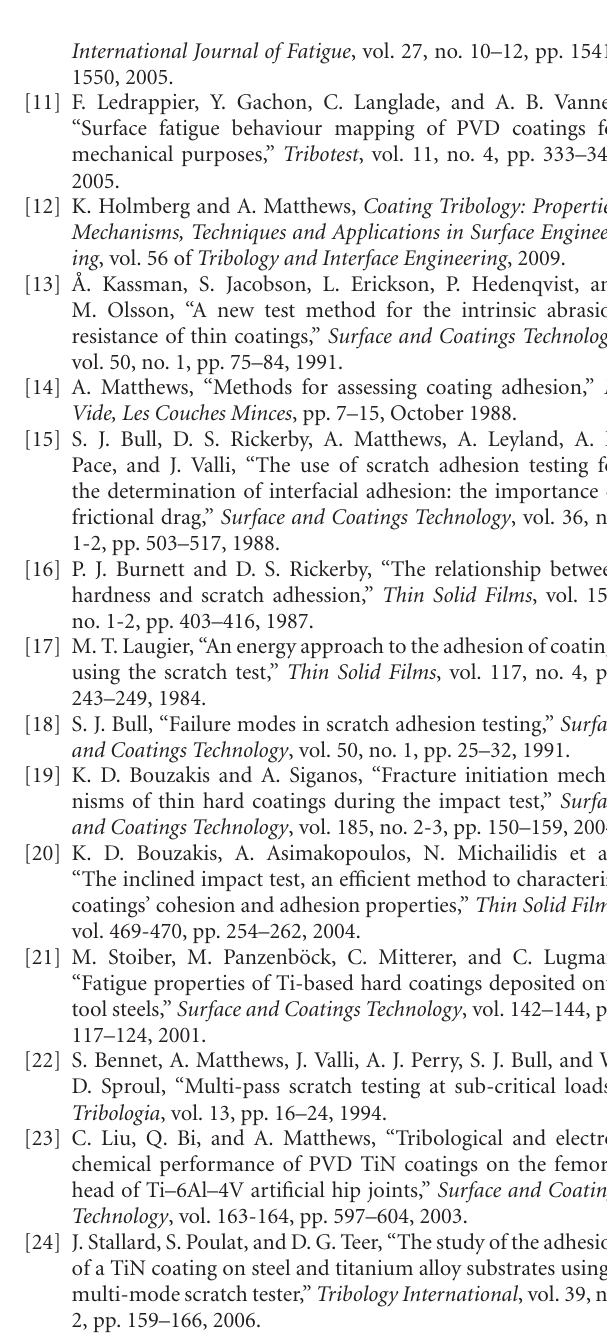
Figure 14: Wear mechanisms observed in Region A corresponding to normalised normal loads <